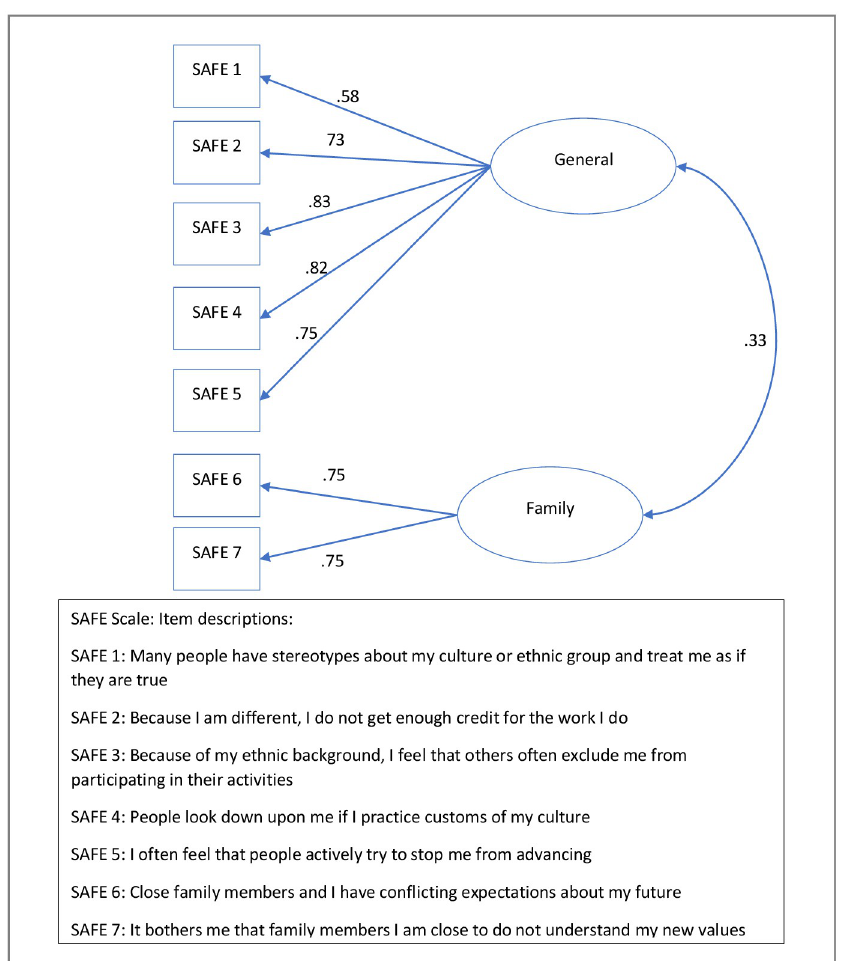
Fig 2. CFA analysis for